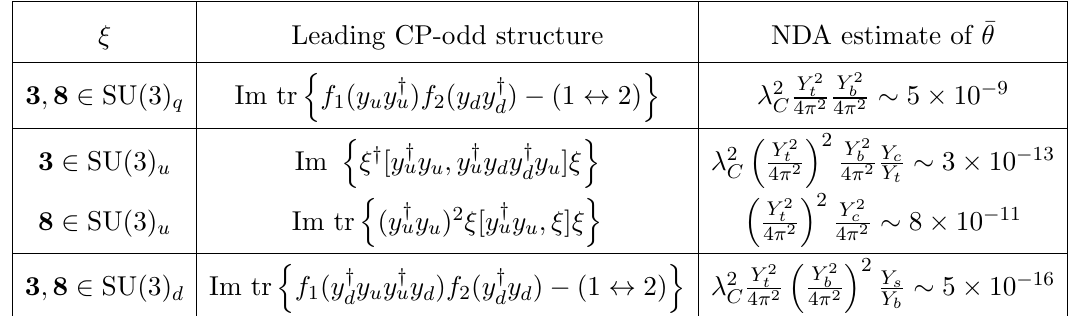
Table 1 . Leading non-decoupling contributions to (cid:22) (cid:18) in an expansion in O ( Y 2 ) for the models of (cid:12)gure 1, with various representations of the CP-odd spurion (cid:24) . The f s are real functions of (cid:24) , with f 1 6 = f 2 . In the last column we estimated (cid:22) (cid:18) using NDA, with the SM Yukawas Y u;d renormalized at 1 TeV, (cid:21) C ’ 0 : 23 the Cabibbo angle, and (cid:24) assumed to be (cid:13)avor-anarchic with entries of order unity.